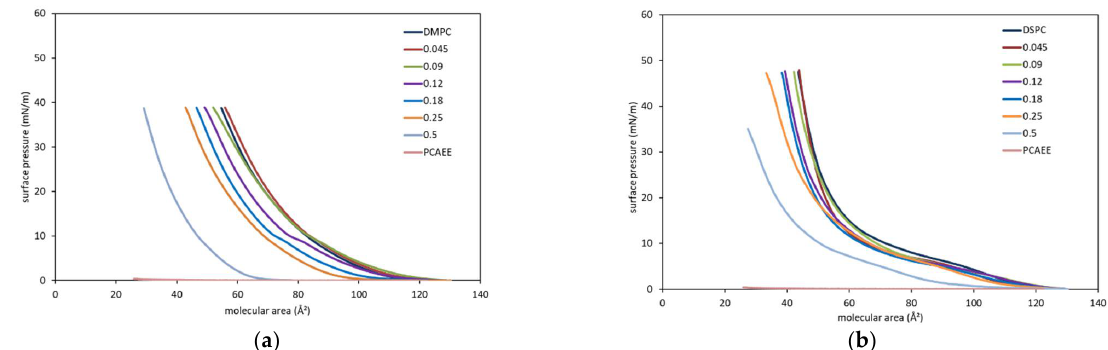
Figure 4. ( a ) Surface pressure/molecular area isotherms of DMPC, PCAEE, and DMPC/PCAEE mixed monolayers at the air–water interface at 37 °C; ( b ) Surface pressure/molecular area isotherms of DSPC, PCAEE and DSPC/PCAEE mixed monolayers at the air–water interface at 37 °C. The curves are the result of three experiments.